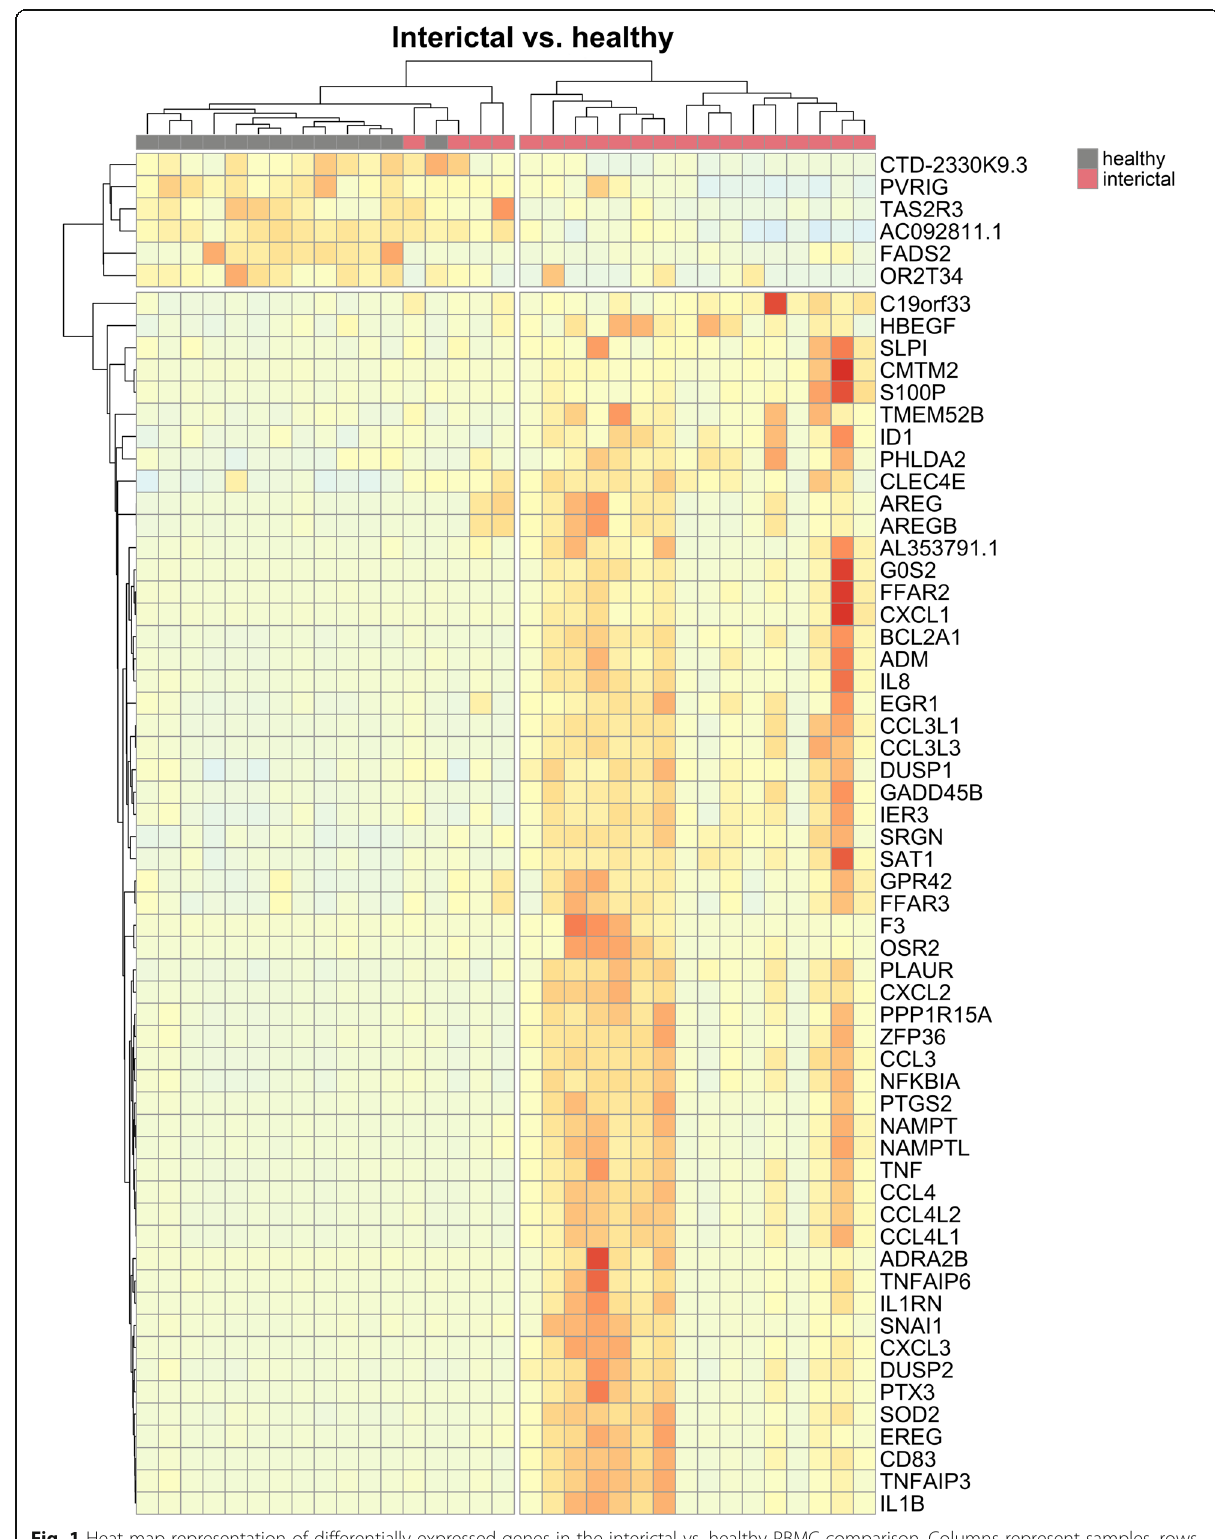
Fig. 1 Heat map representation of differentially expressed genes in the interictal vs. healthy PBMC comparison. Columns represent samples, rows represent genes. Pearson correlation was respectively calculated between samples and genes, visualized by